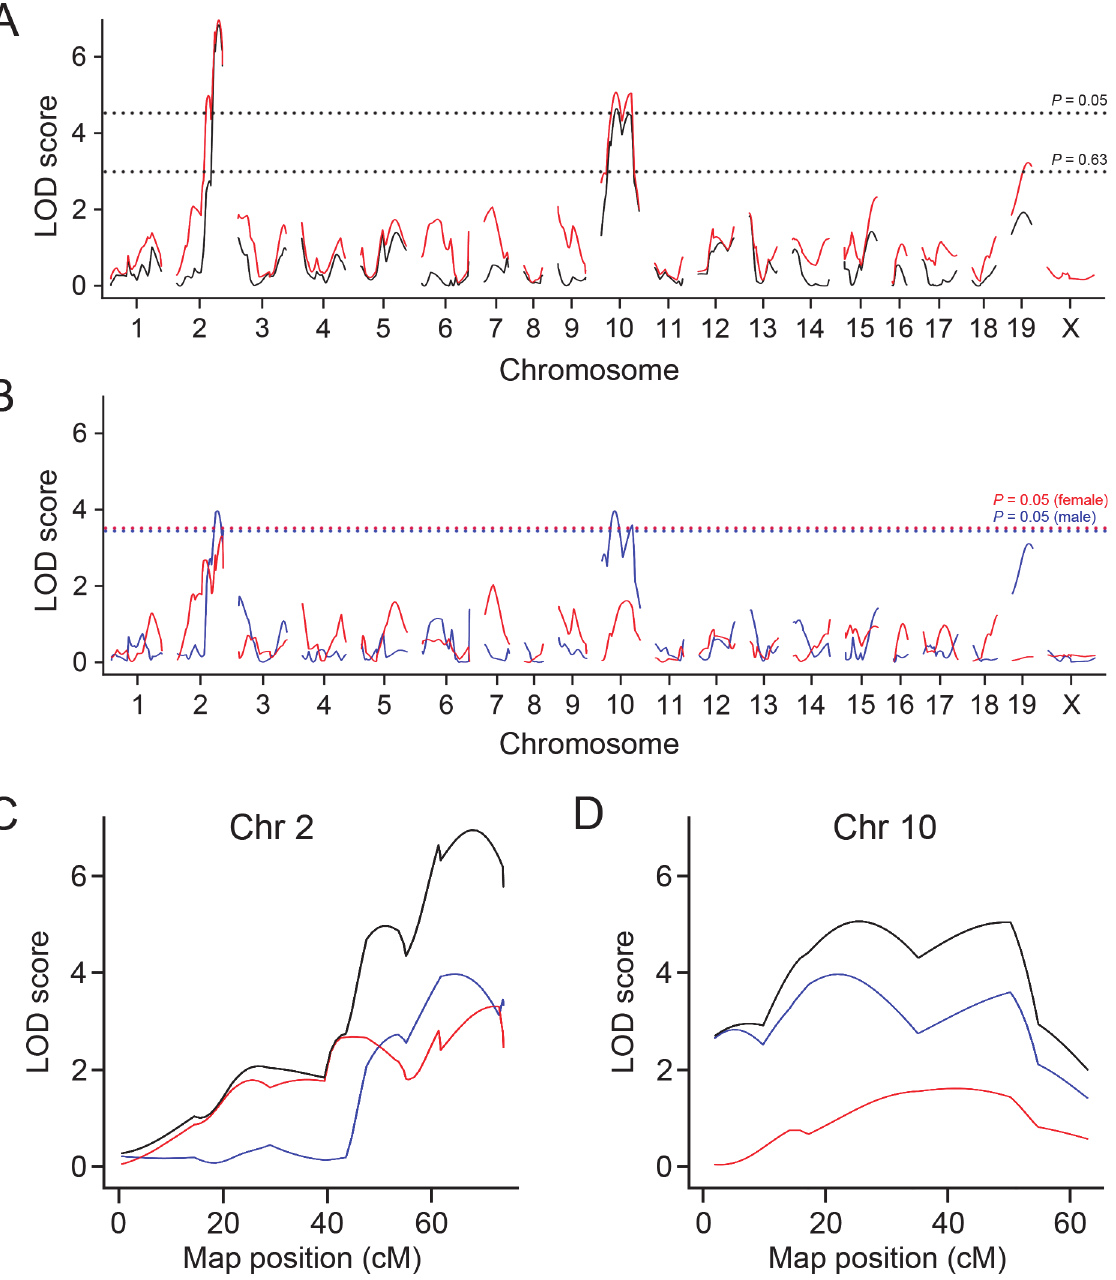
Fig 2. LOD curves for atherosclerotic plaque size at the arch. (A) LOD curves for the arch lesion with sex as an additive covariate (black line) and as an interactive covariate (red line). X-axis represents chromosome number and y-axis represents the LOD score. The horizontal dashed lines represent the thresholds for significant QTL ( P = 0.05) and suggestive QTL ( P = 0.63) in the sex-interactive model. (B) LOD curves for arch lesion in males (blue line) and females (red line). The horizontal dashed lines represent the thresholds for significant QTL ( P = 0.05) in males (blue) and females (red). (C and D) LOD curves for the arch lesion on Chr 2 (C) and Chr 10 (D) with sex as an interactive covariate (black), in males (blue) and in females (red). X-axis represents positions on chromosome (cM) and y-axis represents the LOD score.